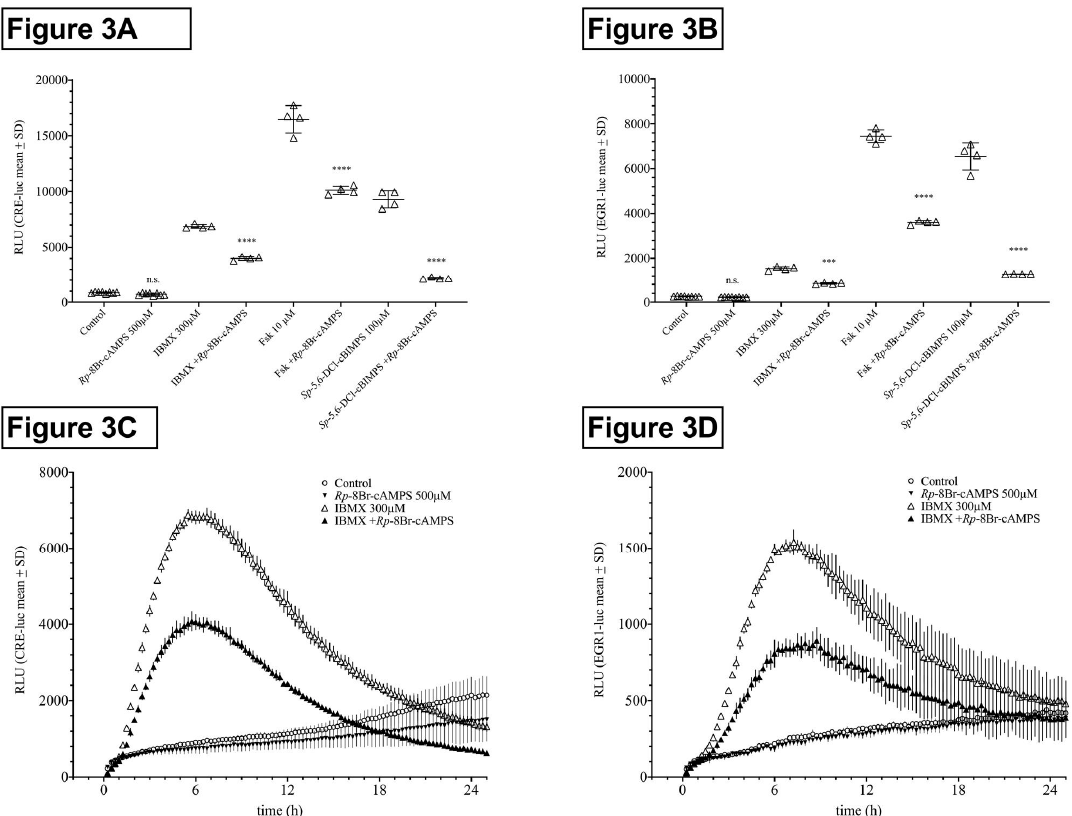
Figure3. HT22CRElucandHT22EGR1lucactivityofIBMXismediatedbyproteinkinaseA(PKA).Reduction in HT22CREluc ( A , C ) and HT22EGR1luc ( B , D ) activity under inhibition of PKA activity due to pre- and co-application of the selective PKA inhibitor Rp -8Br-cAMPS (1 mM during pre-application and 0.5 mM during co-application). In HT22CREluc cells, IBMX-, forskolin-, and Sp -5,6-DCl-cBIMPS-induced activities were 42%, 38%, and 77% lower in the presence of Rp -8Br-cAMPS ( p < 0.0001), respectively, whereas activity under R p-8Br-cAMPS application alone was not significantly lower than that of control. In HT22EGR1luc cells, IBMX-, forskolin-, and Sp -5,6-DCl-cBIMPS-induced activities were 45%, 52%, and 80% lower in the presence of Rp -8Br-cAMPS ( p < 0.0001), respectively, whereas activity under Rp -8Br-cAMPS application alone was not significantly lower than that of control (mean ± SD; N = 4–8). Time courses of HT22CREluc (C) and HT22EGR1luc (D) activity for IBMX and IBMX plus Rp -8Br-cAMPS. All data are from the Centro luminometer.